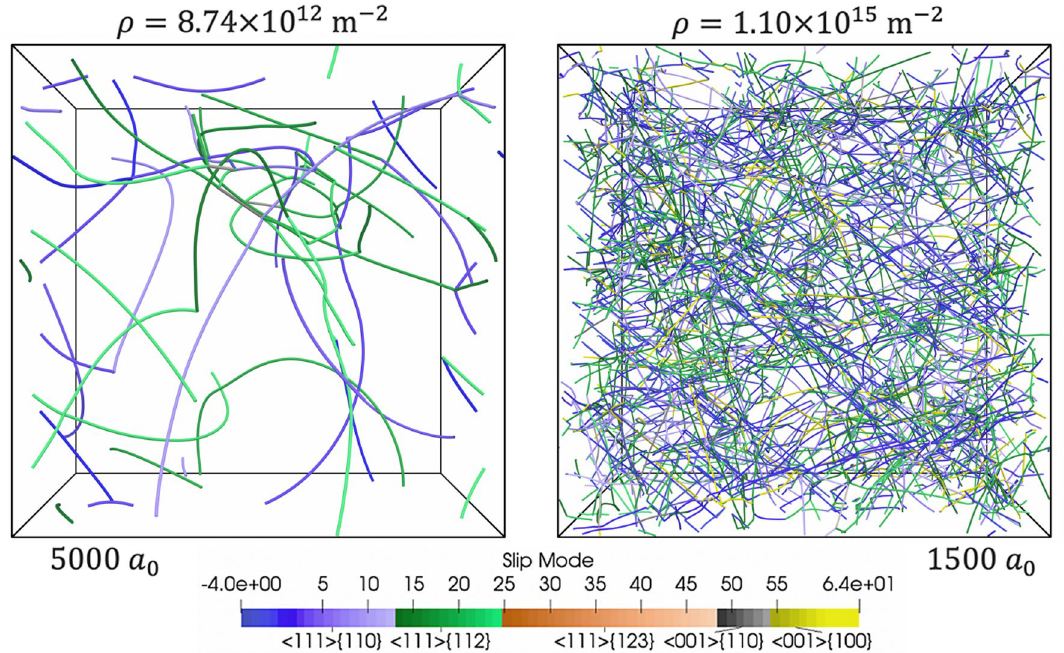
Figure 3. Two simulated microstructures of different dislocation densities, with slip systems labelled by slip